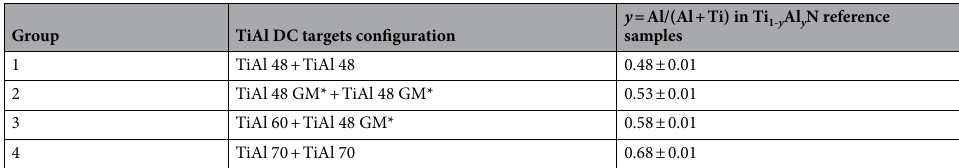
Table 1. The list of target configurations used to deposit (Ti 1- y Al y ) 1- x W x N films with varying Al/(Al + Ti) ratio. *GM refers to the target with different arrangement of Al plugs along the racetrack resulting in higher Al content in the films for the same number of Al